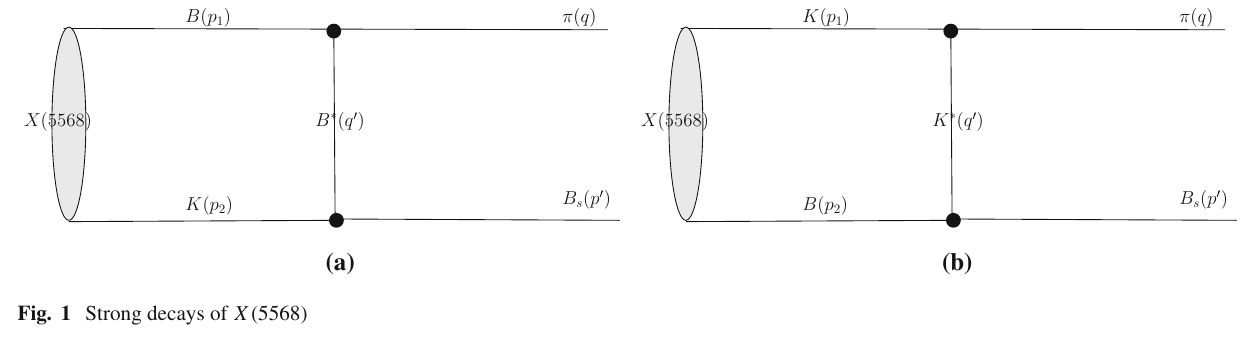
Fig. 1 Strong decays of X ( 5568 )